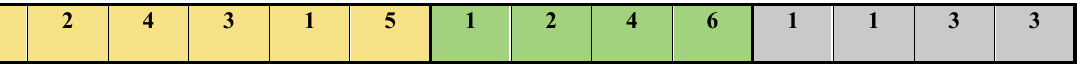
Fig. 1. The representation of the